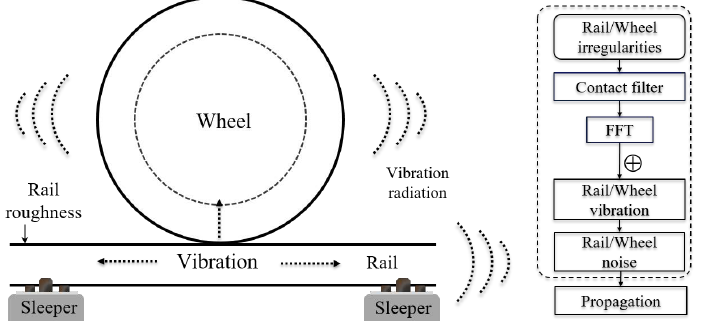
Figure 1. Generation of rolling noise with the TWINS